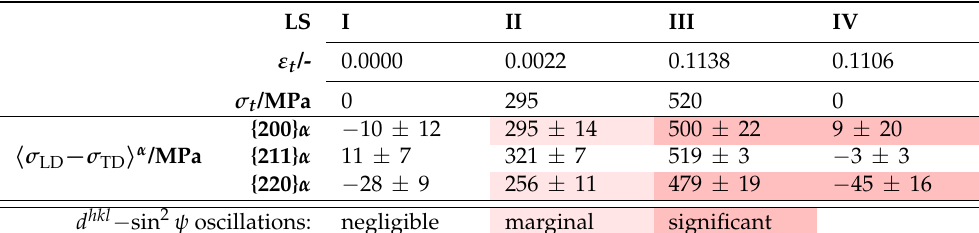
Table 4. Stresses in the ferritic phase (cid:104) σ LD − σ TD (cid:105) α of the FSS for different load states (LS) at the applied true stress σ t and the true strain ε t ; evaluation according to sin 2 ψ method.